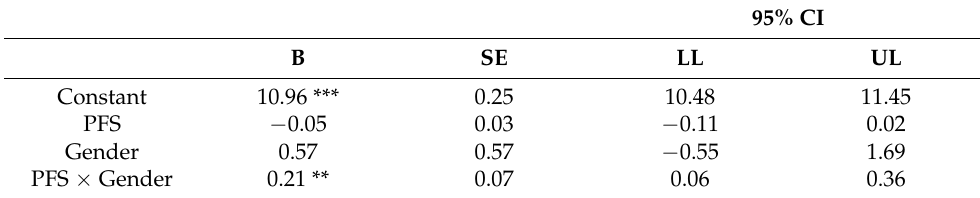
Table 13. Unstandardized regression coefficients for Model 3.